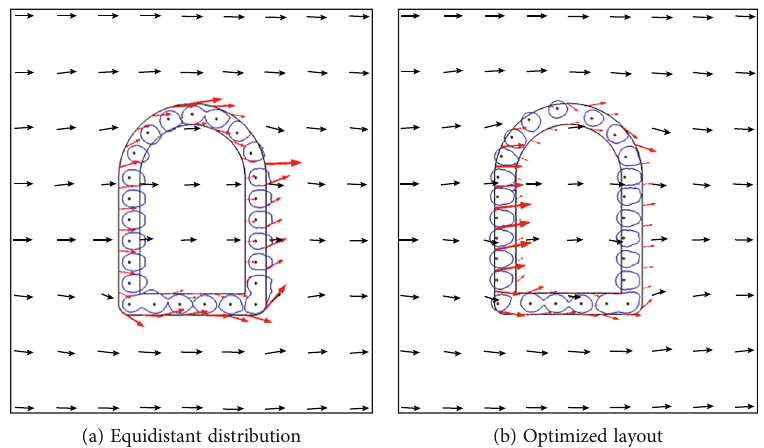
Figure 7: Frozen wall and seepage fl ow at freezing duration of 20